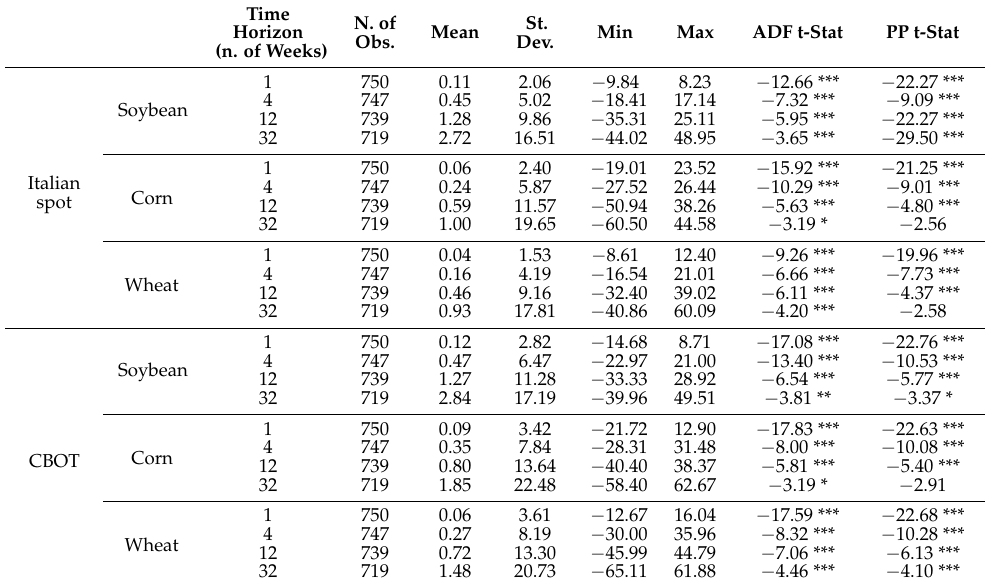
Table 1. Returns descriptive statistics and stationarity tests.